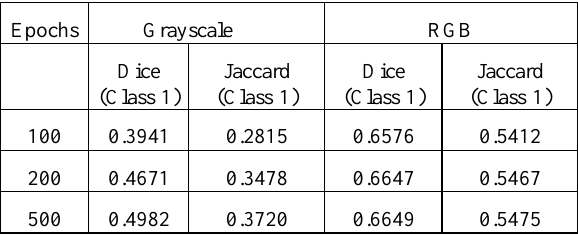
Figure 6: Images that have the target epiphyte under good illumination and high